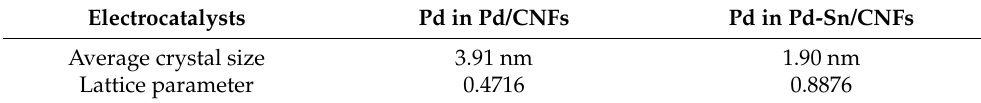
Figure 3. XRD patterns of CNFs support, Pd/CNFs and Pd-Sn/CNFs electro-catalysts. Table 1. Average crystal sizes and lattice parameters of Pd in the